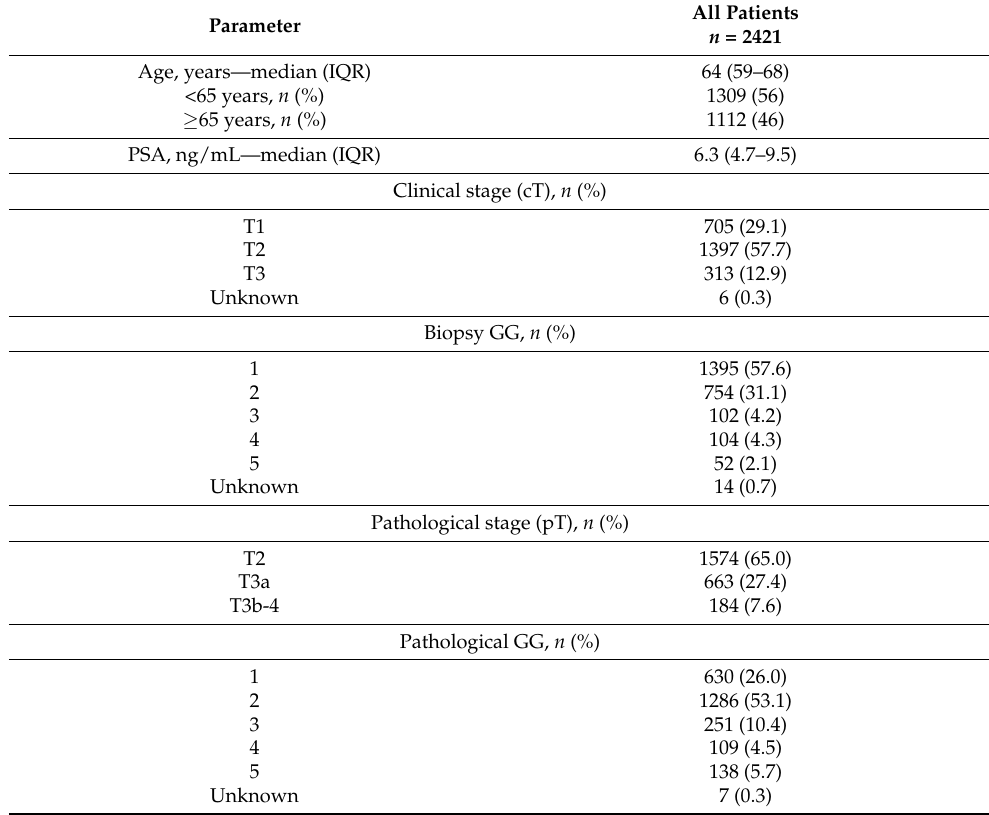
Table 1. Descriptive characteristics of 2421 prostate cancer patients treated with radical